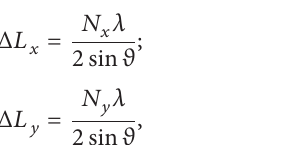
Figure 6: Average strain developed in the transistor with the